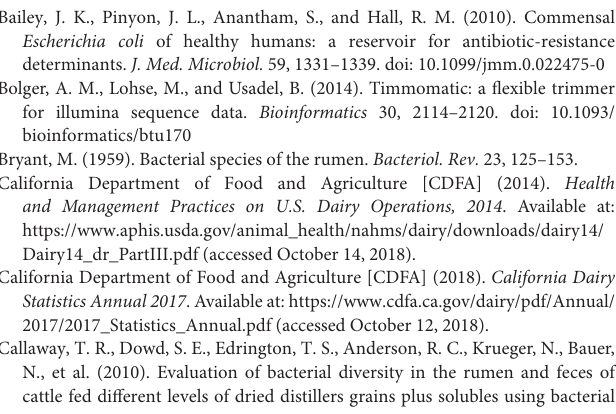
FIGURE S1 | Beta diversity of samples graphed as PCoA of unweighted UniFrac distances colored by Farm. Clustering shows some farms have greater diversity within farm individuals. Farm 9 and Farm 6 clustered tightly while individual samples from Farm 8 showed greater variability. This clustering pattern illustrates the bacterial community structure varies across individual farms to a smaller extent with housing type being the dominant factor. TABLE S1 | Metadata for each sample used for analysis. TABLE S2 | Presence or absence of specific feedstuffs in diet of farms where feed information was collected. TABLE S3 | The full output of differential abundance testing as determined by DESeq2. All differentially abundant OTUs are listed with their assigned taxonomy. Columns are as follows baseMean is the average of the normalized count values, log2FoldDifference is the effect size estimate and lfcSE is the standard error estimate for the log2 fold change estimate. The subsequent columns are the Wald test statistic its p -value and adjusted p-value as calculated by the Benjamini-Hochberg (BH) adjustment for multiple tests. TABLE S4 | A subset of farms (2–3, 7–8, 10) that had complete records of metadata were analyze with MaAsLin in R. All OTUs associated with individual metadata as determined are listed with their assigned taxonomy, coefficients, p and q